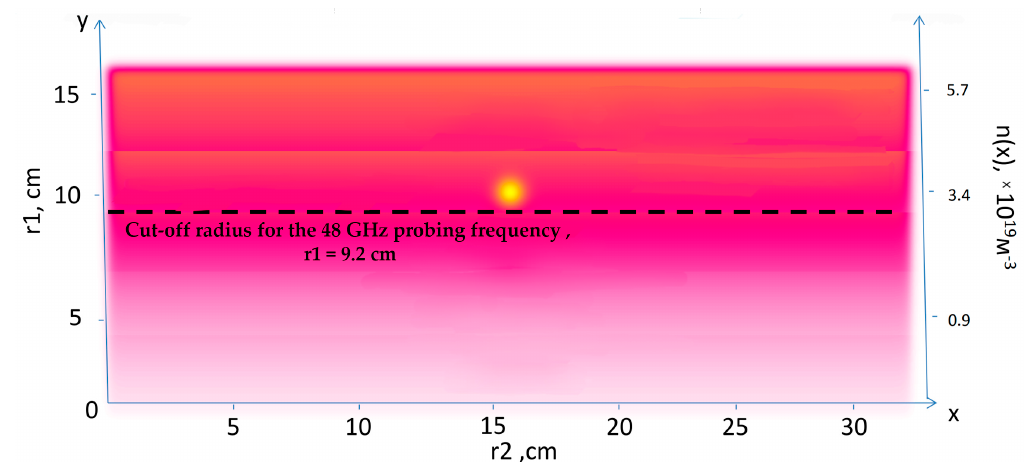
Figure 4. Density perturbations with an introduced circular filament (yellow circle).